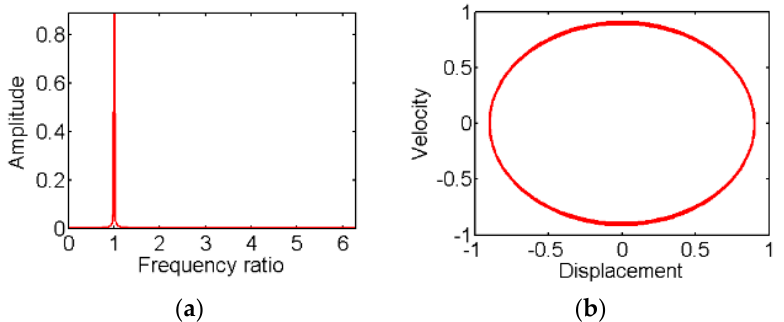
Figure 6. Dynamic behavior of the normal rotor system. ( a ) Spectrogram; ( b ) Phase Diagram.